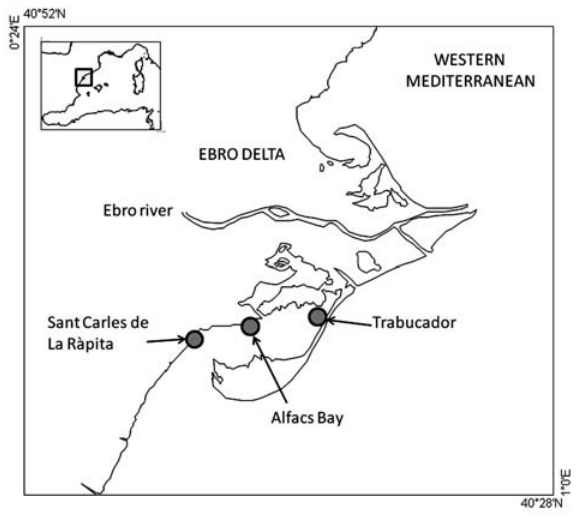
Fig . 1. – Location of the reported records of the exotic crab Dyspan- opeus sayi in the Ebro Delta (western